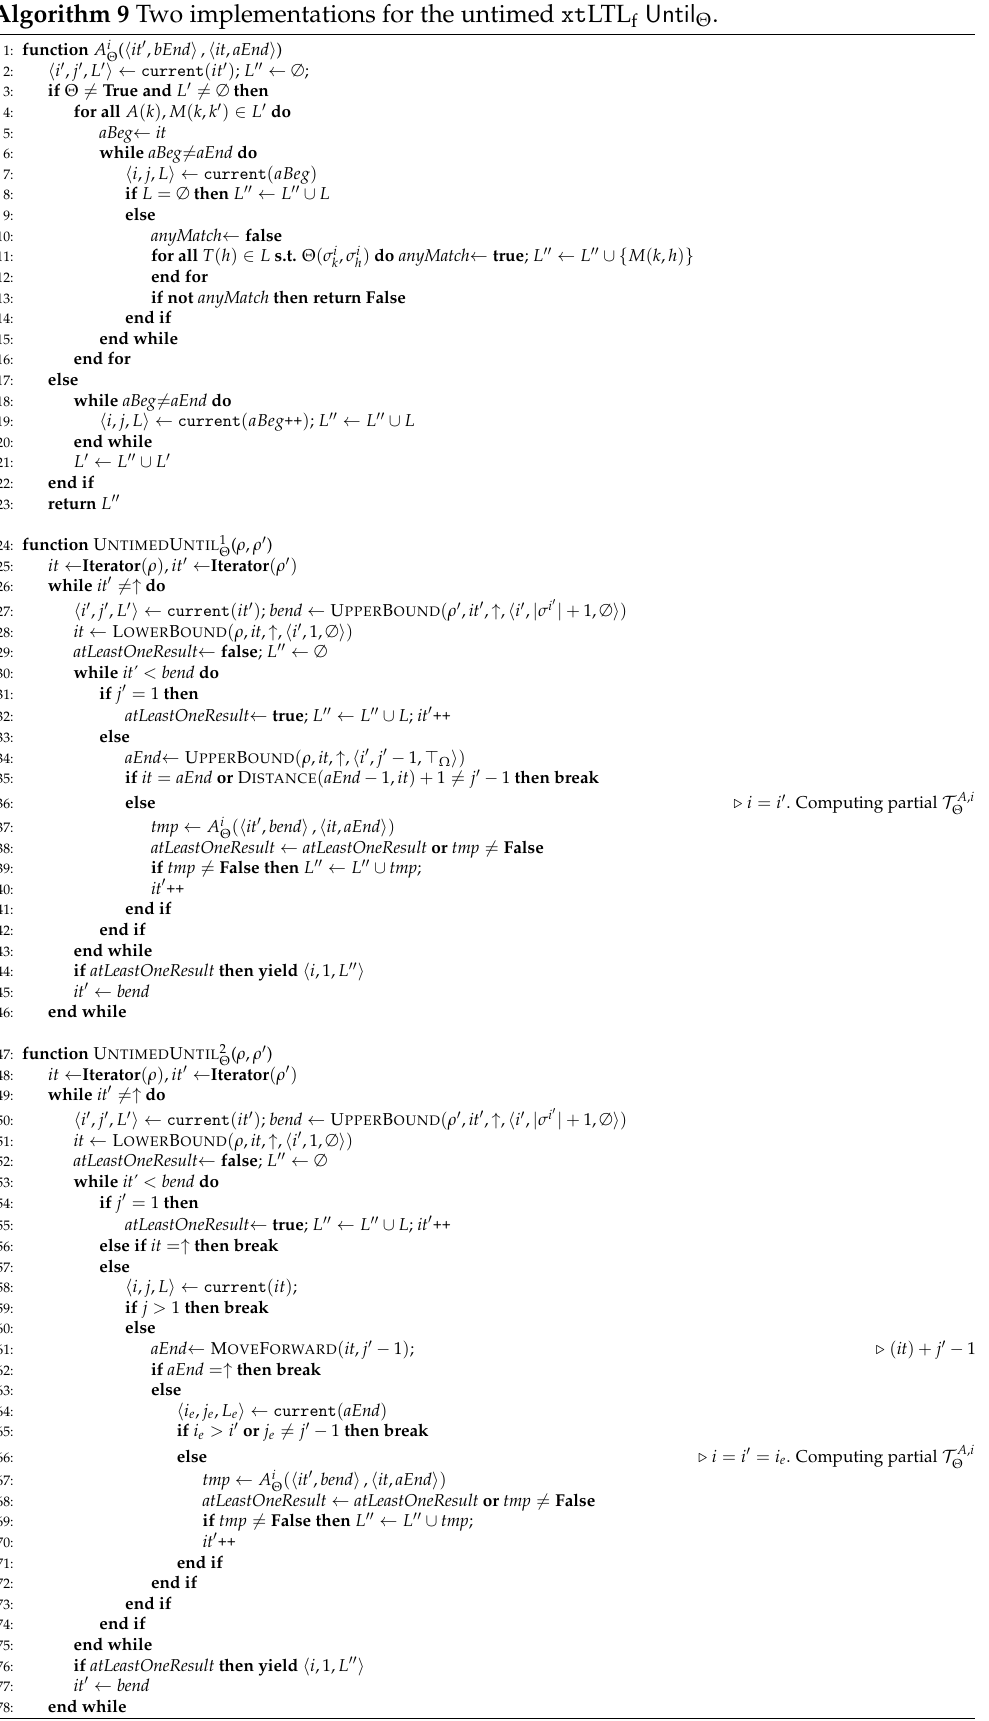
Algorithm 9 Two implementations for the untimed xt LTL f Until Θ